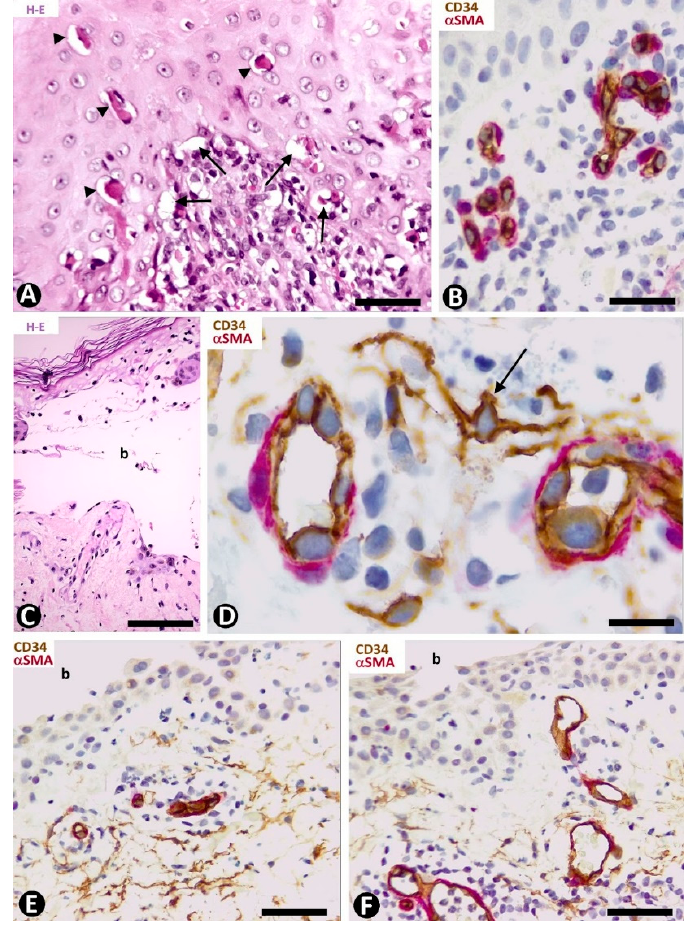
Figure 6. CD34+SCs/TCs in Erythema multiforme ( A – D ) and Pemphigus ( E , F ). ( A , C ) Hematoxylin- eosin staining. ( B , D – F ) Double immunochemistry for CD34 (brown) and α SMA (red). Hematoxylin counterstain. ( A , B ) Early lesion of erythema multiforme, with hydropic degeneration of basal cells (arrows), cytoid bodies (arrowheads) and lymphocytic infiltrate ( A ), in which CD34+SCs/TCs are not observed in the superficial areas ( B ). ( C , D ) A blister (C, b) in erythema multiforme with the presence of CD34+SCs/TCs (arrow) in the underlying dermis ( D ). ( E , F ) Intraepidermal blister (b) in which the roof is not shown. In the underlying dermis CD34+SCs/TCs are present ( E ) or absent ( F ) around some vessels. Bar: ( A ) 55 µm, ( B , E , F ) 45 µm, ( C ) 80 µm, ( D ) 25 µm.